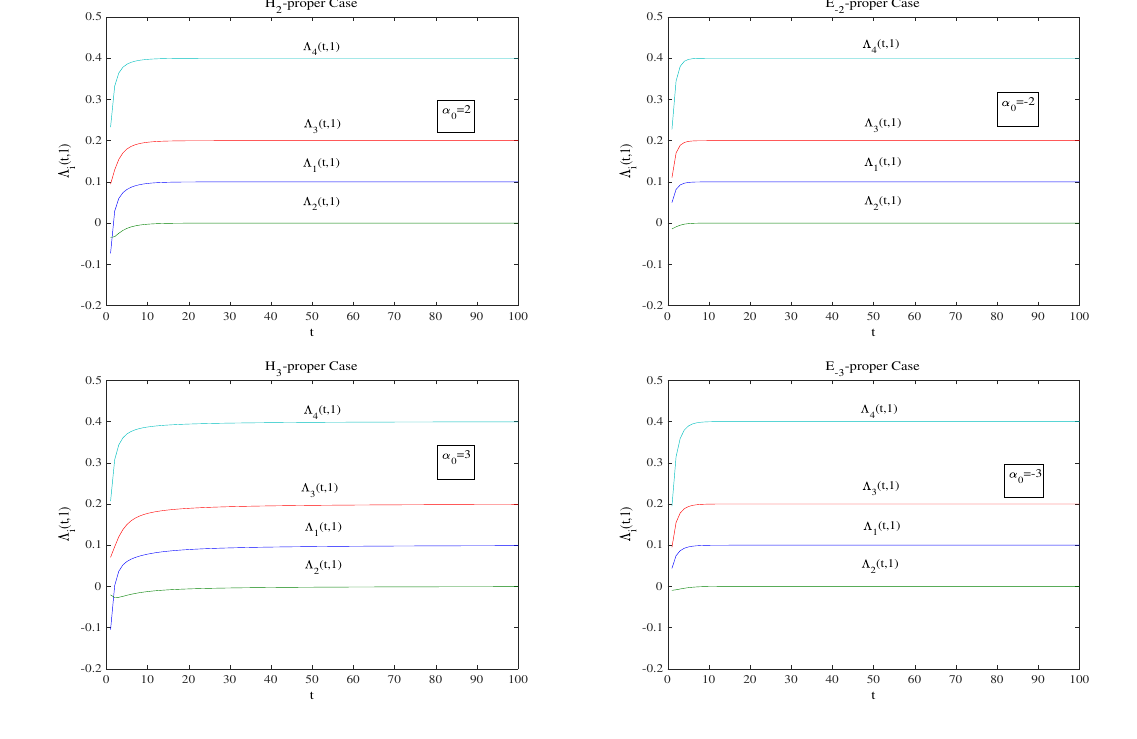
Figure 4. Values of the components Λ i ( t ,1 ) , i = 1, . . . ,4, for α 0 = − 3, − 2, −